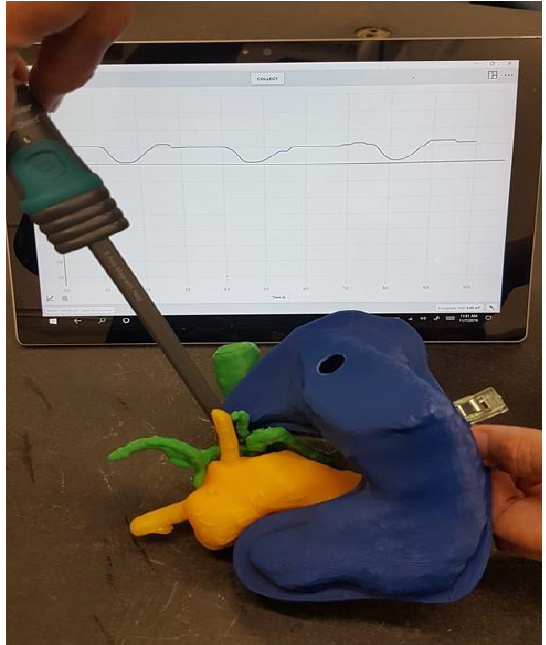
Figure 11. Measurement of the magnetic field where the tumor infiltrated the vessels.